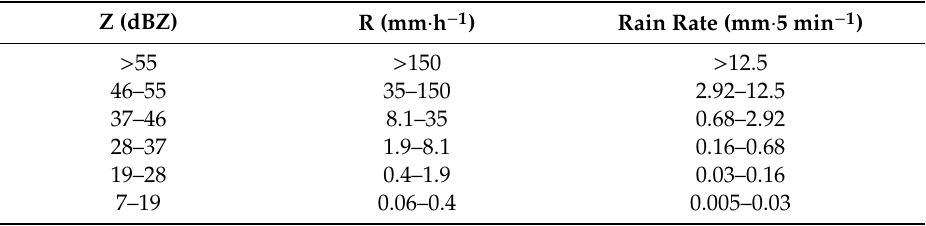
Table 1. Conversion of radar reflectivity to rain rates using the Z–R relationship (a = 256, b = 1.42) with thresholds according to the classification of the